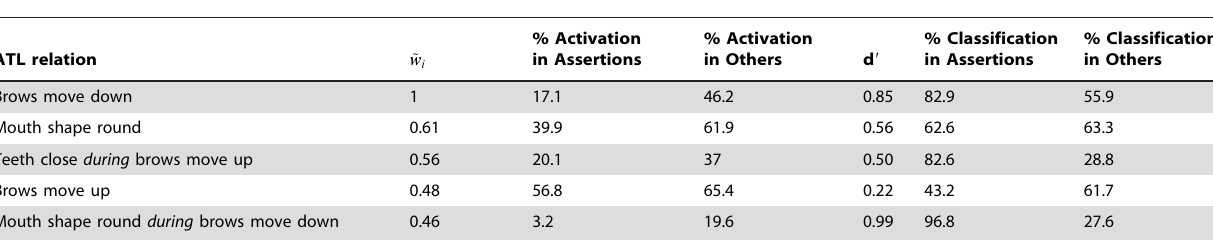
Table 7. Discriminant features for